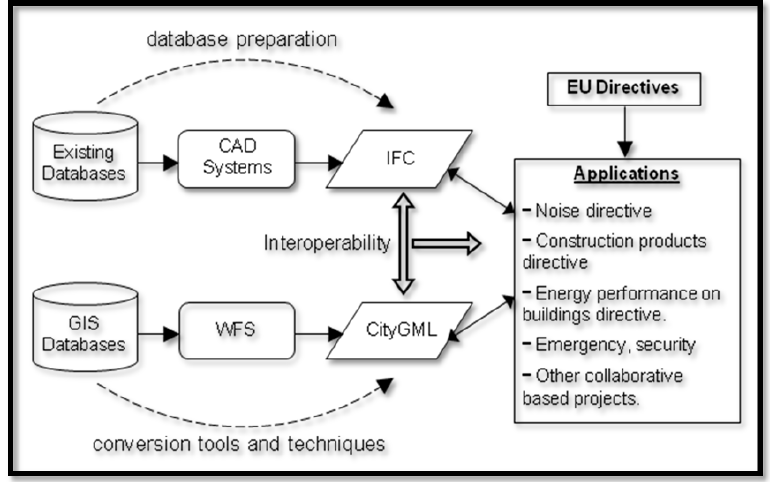
Figure 3. Proposed conceptual model for CityGML and IFC